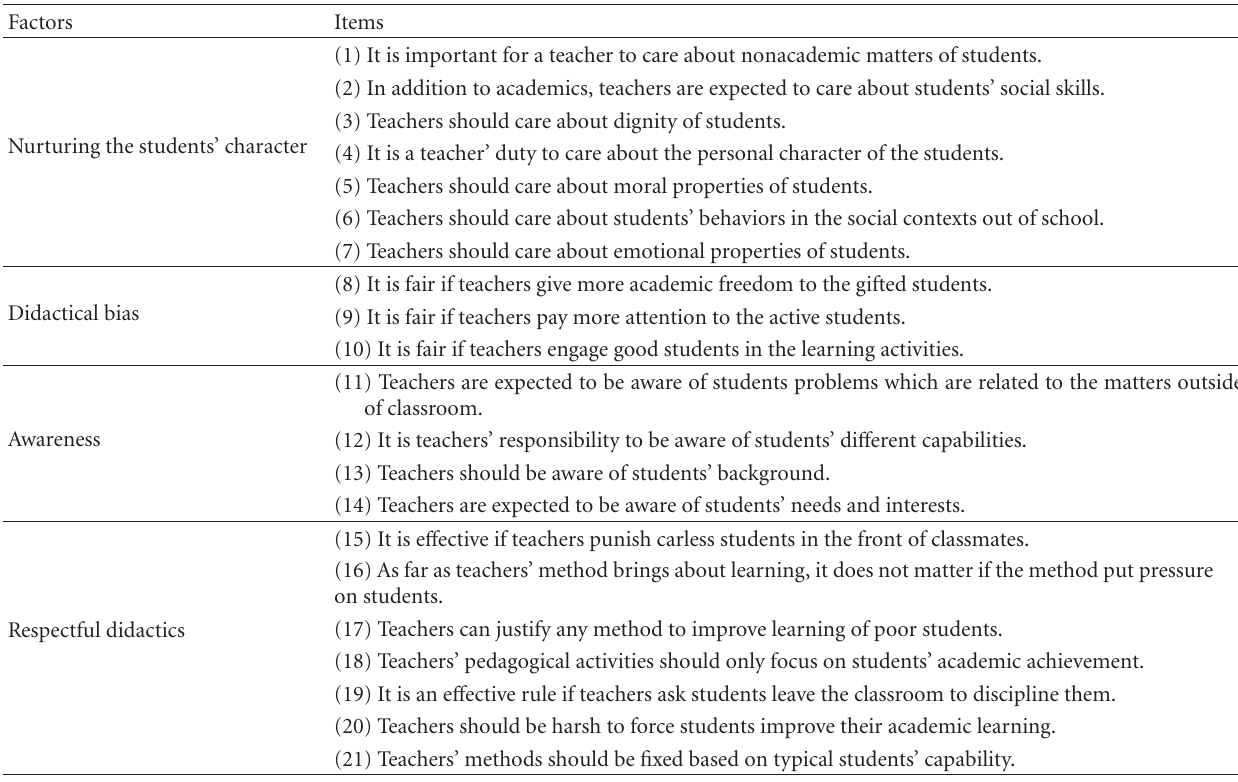
Table 6: The final items included in the caring teaching